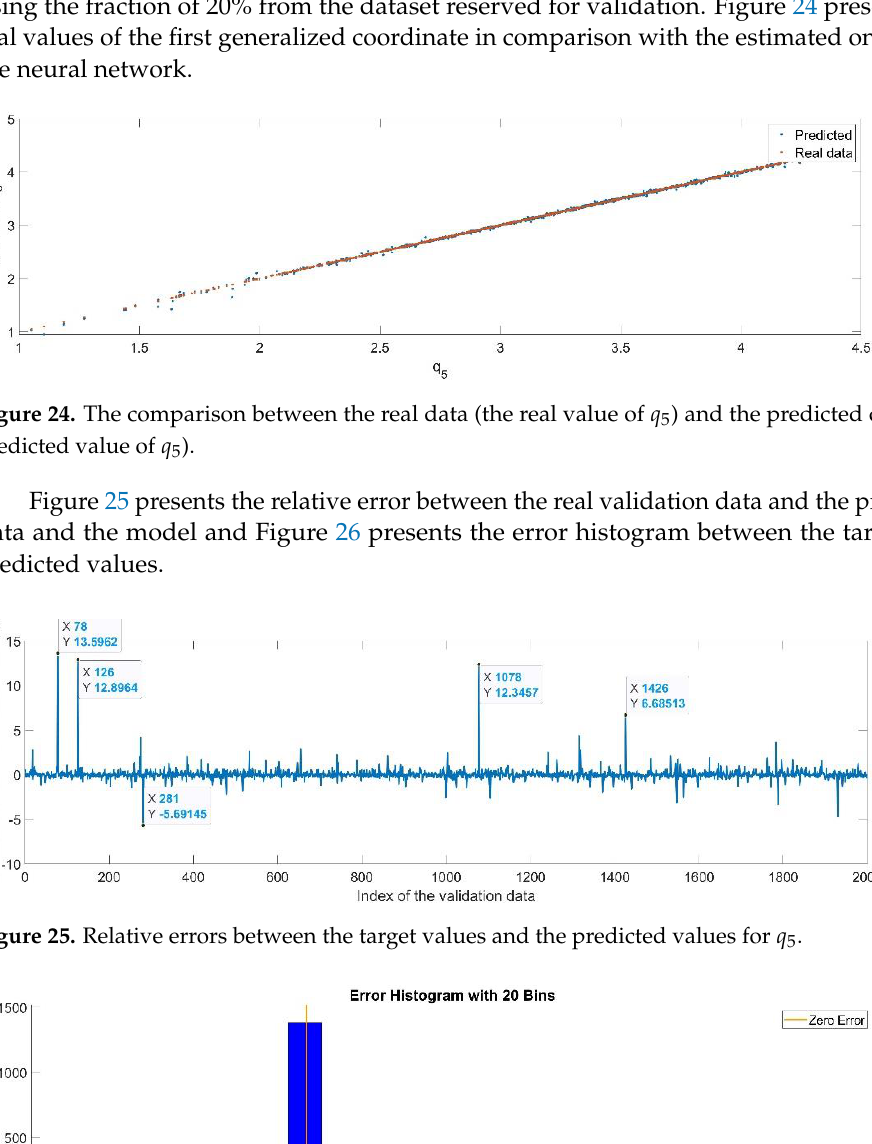
Figure 23. Convergence of the neural network for the first generalized coordinate 𝑞 5 (log scale).